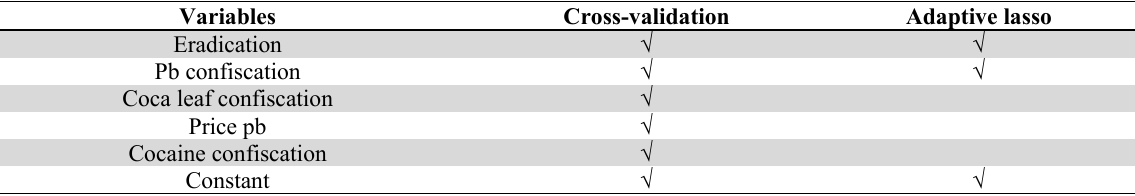
Selected variables